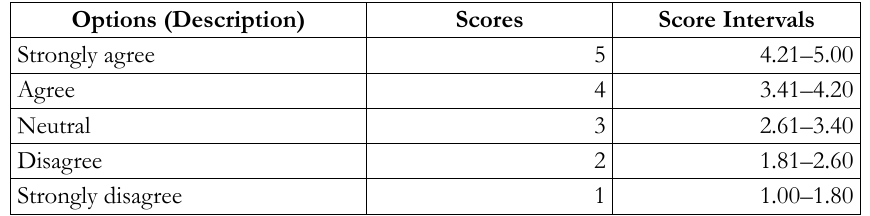
Table 5. The evaluation of scale data based on the scale options and score intervals